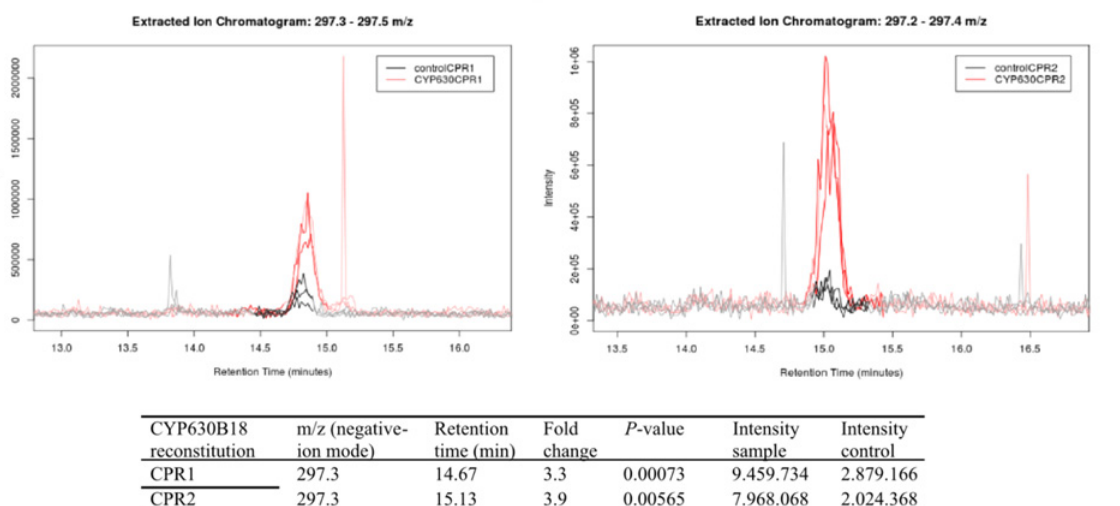
Fig 1. Oleic acid oxidation by Gs CYP630B18 in combination with Gs CPR1 or Gs CPR2. Extracted ion chromatograms (297.2 – 297.4 m/z, run in negative-ion ESI-MS) for oleic acid conversion by GsCYP630B18 in combination with GsCPR1 or GsCPR2 with the highest peak (m/z 297.3) identified as 18-hydroxyoleic acid. Darkened lines indicate where the peaks were integrated for relative ion intensity comparison. Samples GsCYP630 with GsCPR1 (top left panel) and GsCYP630 with GsCPR2 (top right panel) are shown in red. Controls (empty E. coli membrane fractions with GsCPR1or GsCPR2) are shown in black. Significant differences for the major product peak between controls and samples were indicated by P-value (P < 0.05, n = 3). Additional data for each analysis are shown below the LC/MS traces as m/z value, retention time, fold change as ratio of mean intensities between samples and controls, P- value, and peak intensity as average feature intensity within sample/control class.